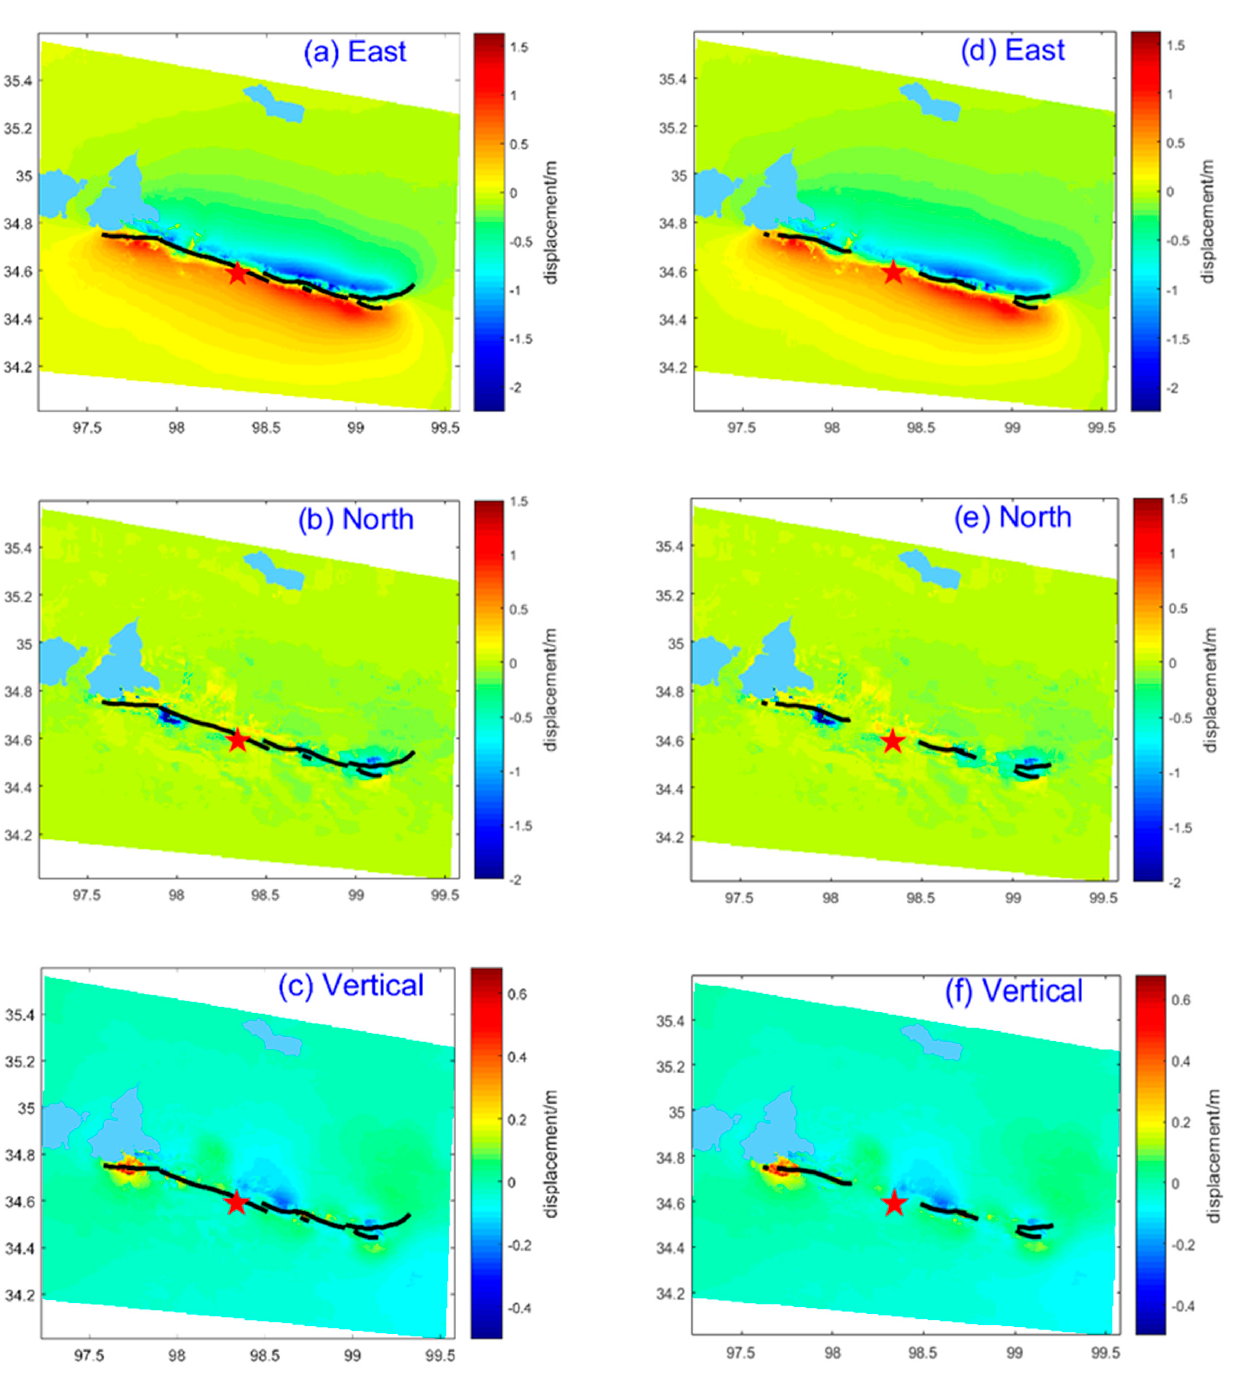
Figure 4. The co-seismic three-dimensional deformation field of the 2021 Maduo M S 7.4 earthquake: ( a , d ) the displacement of the east–west direction; ( b , e ) the displacement of the north–south direction; ( c , f ) the displacement of the vertical direction. In Figure 4a–c, the black line is the fitted rupture from the filed investigation [44] and the InSAR deformation field in this study. In Figure 4d–f, the black line is the surface rupture from the fine interpretation from the unmanned aerial vehicle (UAV), the red star represents the epicenter of the Maduo M S 7.4 earthquake.